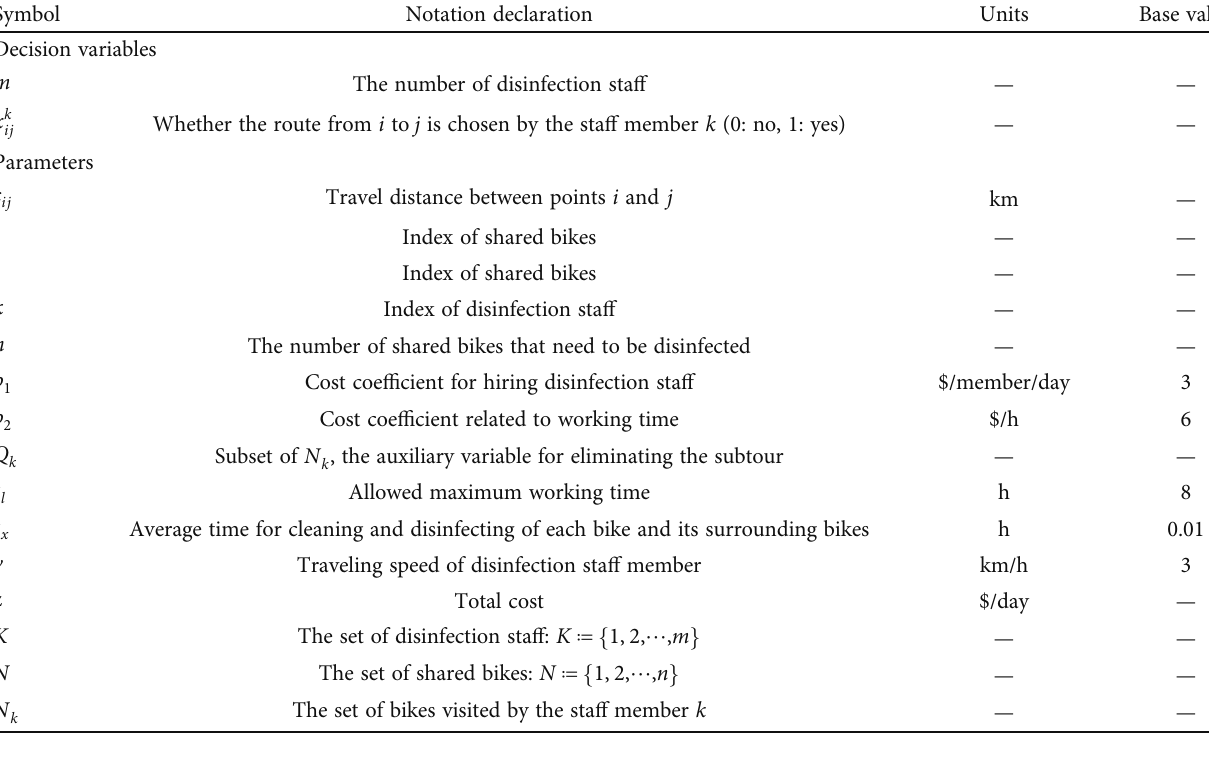
Table 1: Notation and base values.